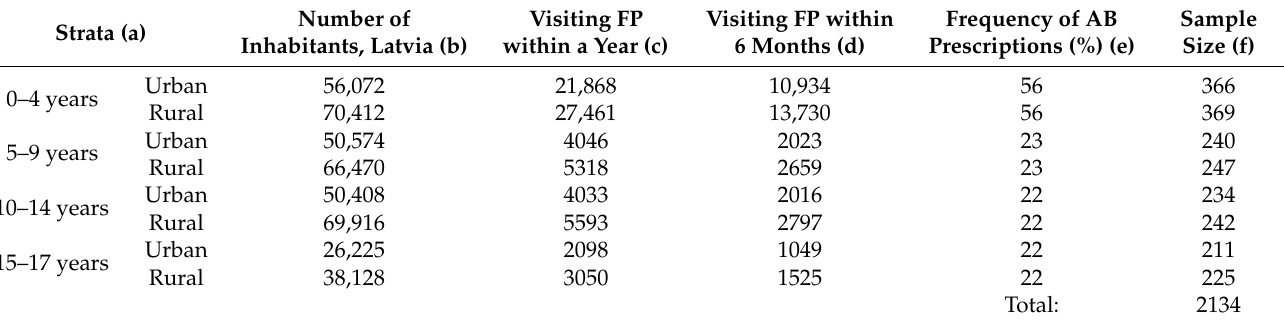
Table 1. Size of the target population and the study